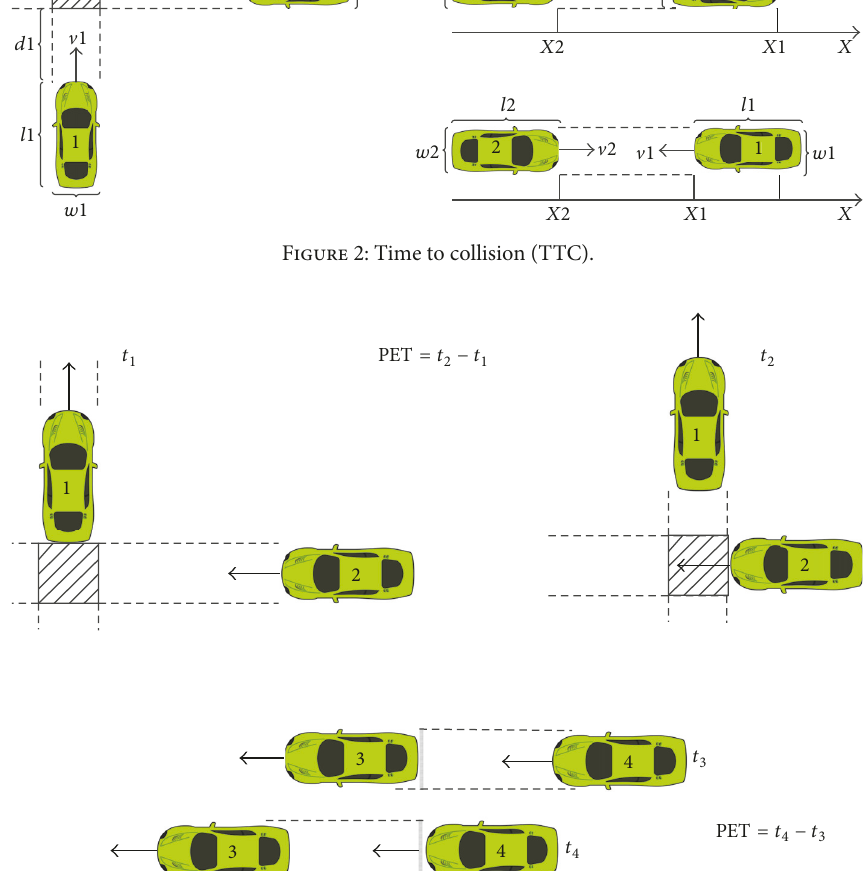
Figure 3: Postencroachment time (PET).